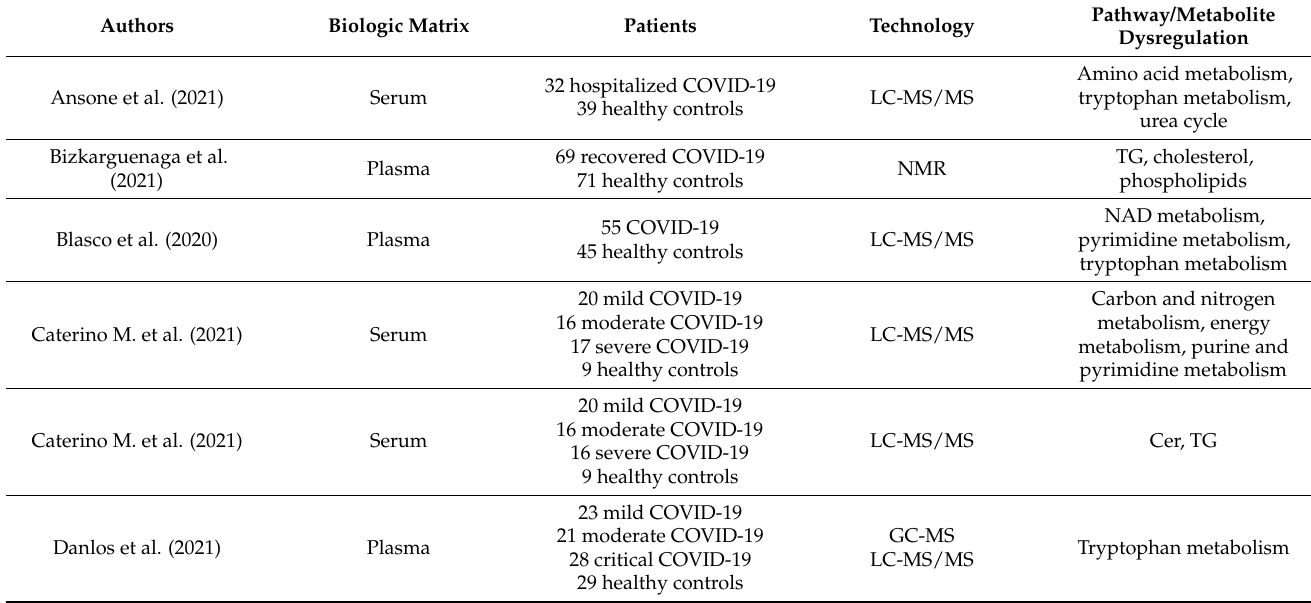
Table 2. Summary of the main characteristics of the metabolomics and lipidomics publications related to COVID-19